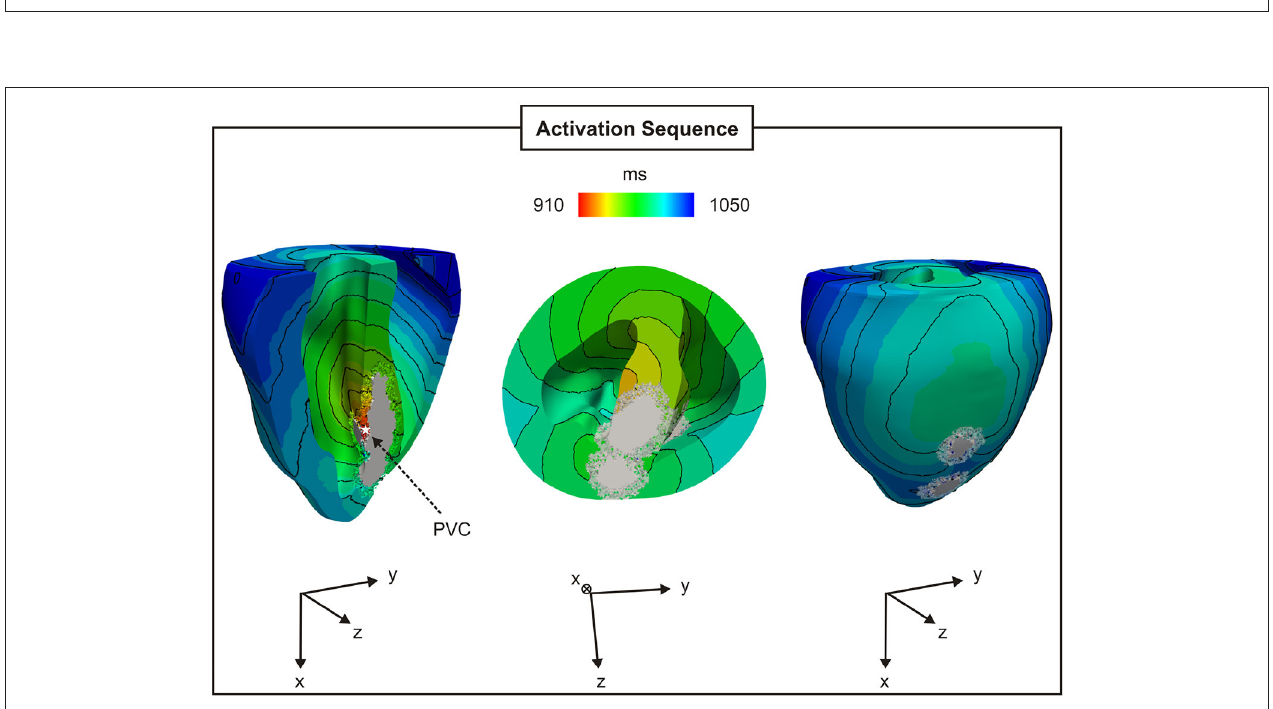
FIGURE 11 | PVC formation in the rabbit BiV model with FIB BZ = 90%. Activation sequence on the endocardial and epicardial surfaces of a PVC originating between two scars in the intraventricular septum (star).